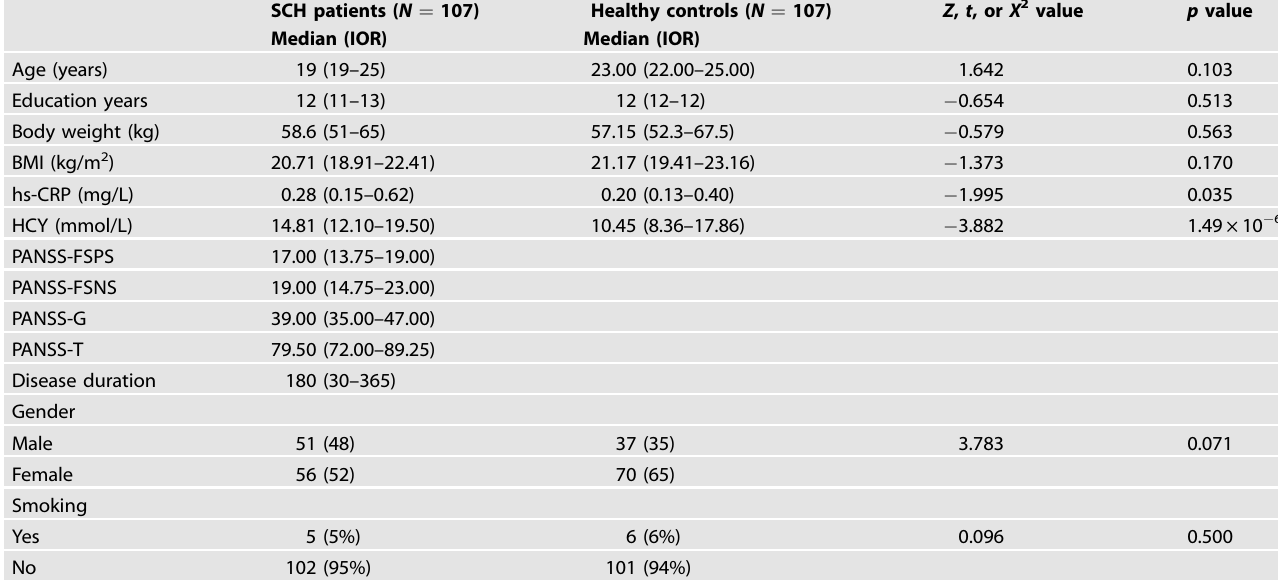
Table 1. Demographic characteristics and statistical